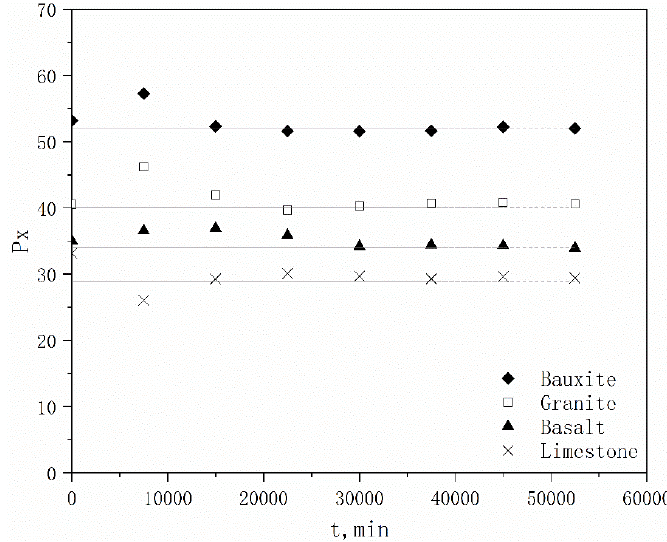
Figure 8. P x values as a function of time t for each aggregate.